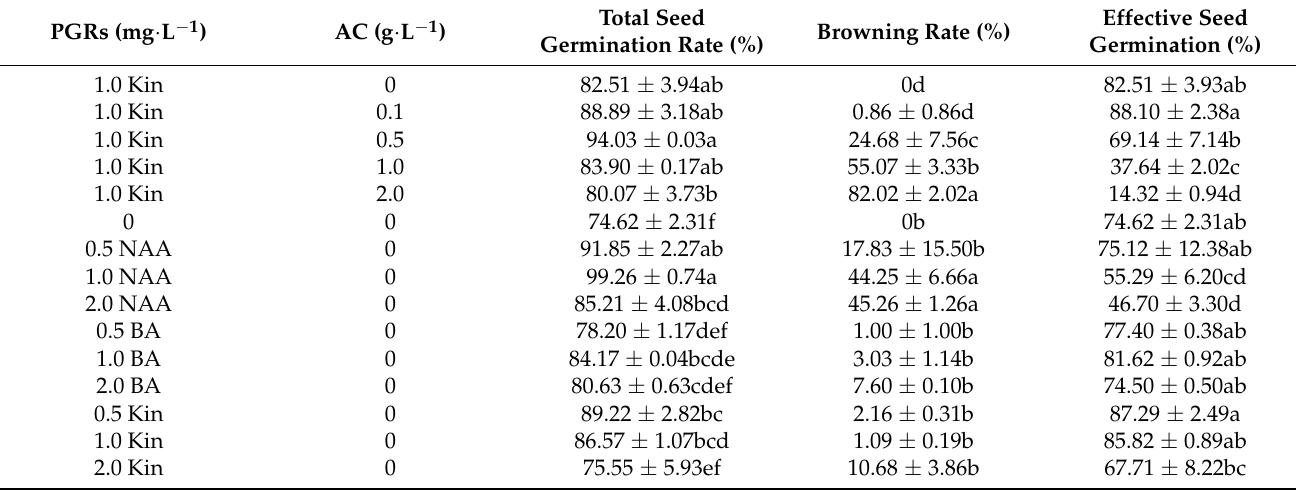
Table 2. Effect of activated charcoal and plant growth regulators on seed germination of Paphiopedilum tigrinum . PGRs (mg · L − 1